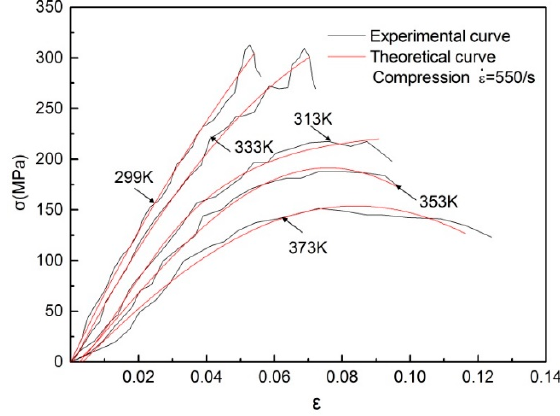
Figure 18. Comparison of model predictions with experimental data on directional polymethylmethacrylate of Suo et al. [30].